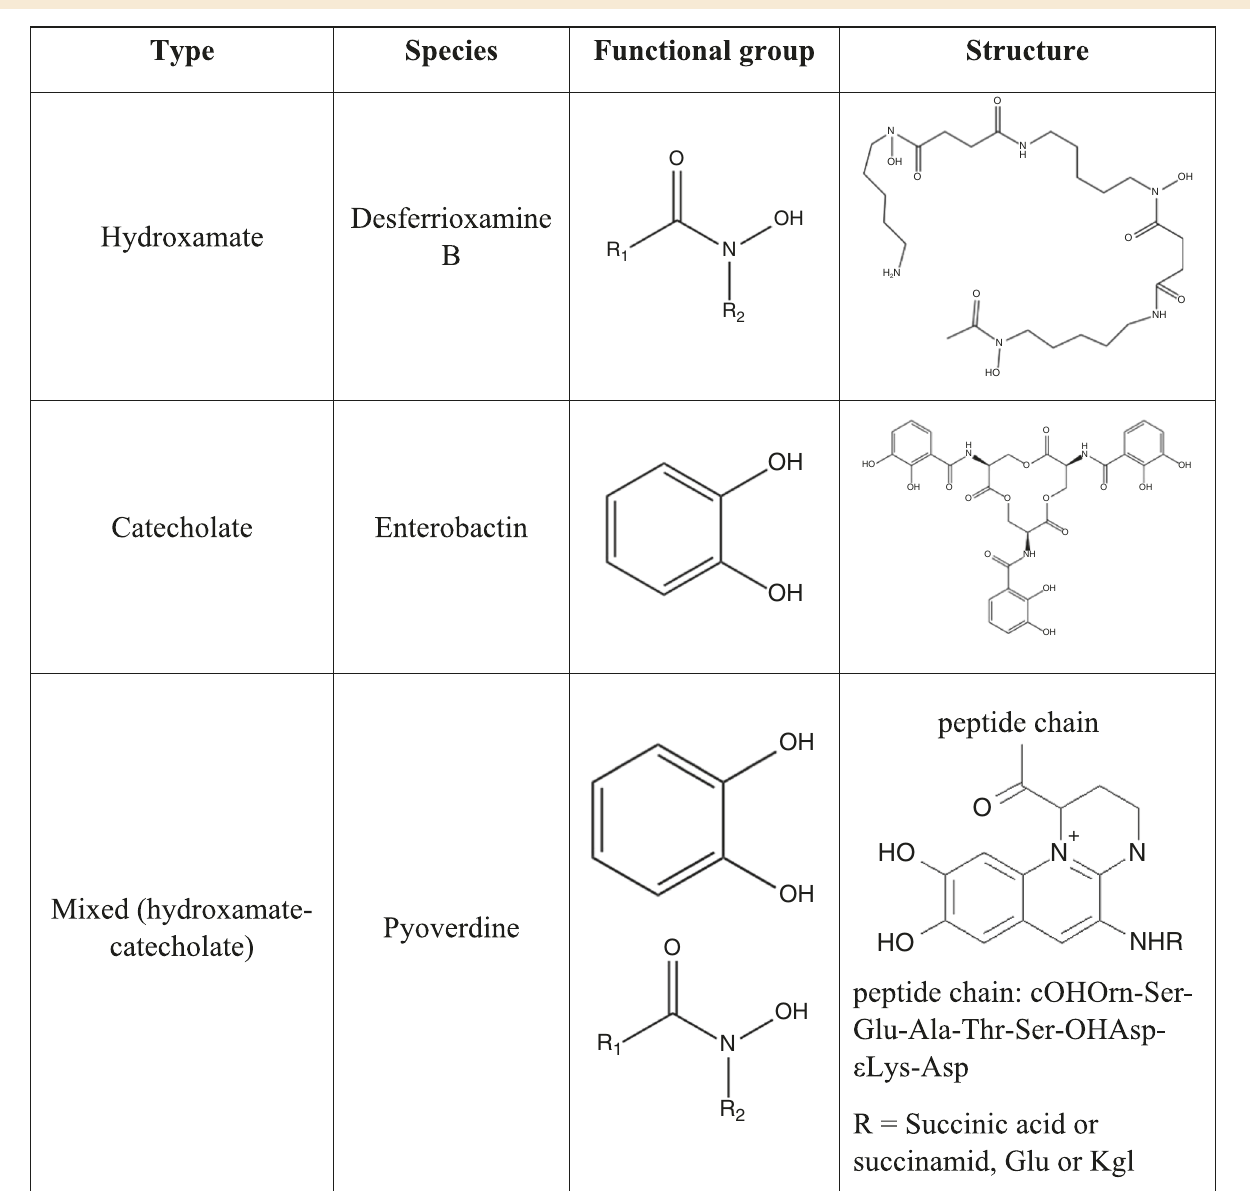
Table 1 Type and structures of siderophores used in this